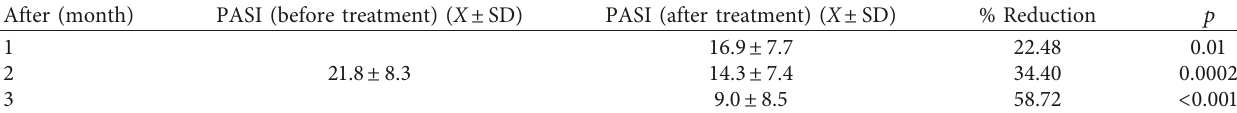
Table 3: Treatment results of the study group ( n � 35).